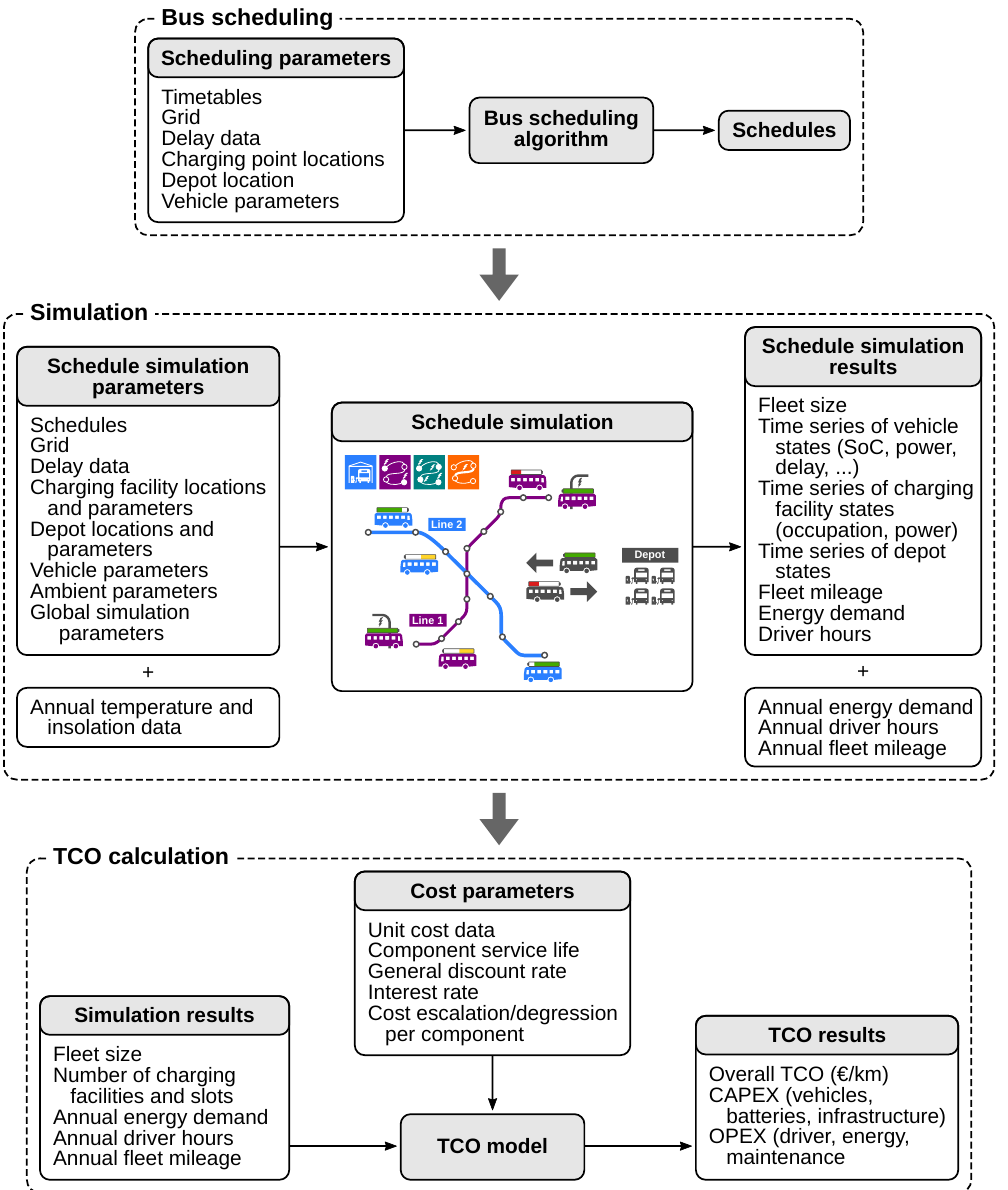
Figure 3. Overview of eFLIPS (Electric Fleet and Infrastructure Planning/Simulation) main features and